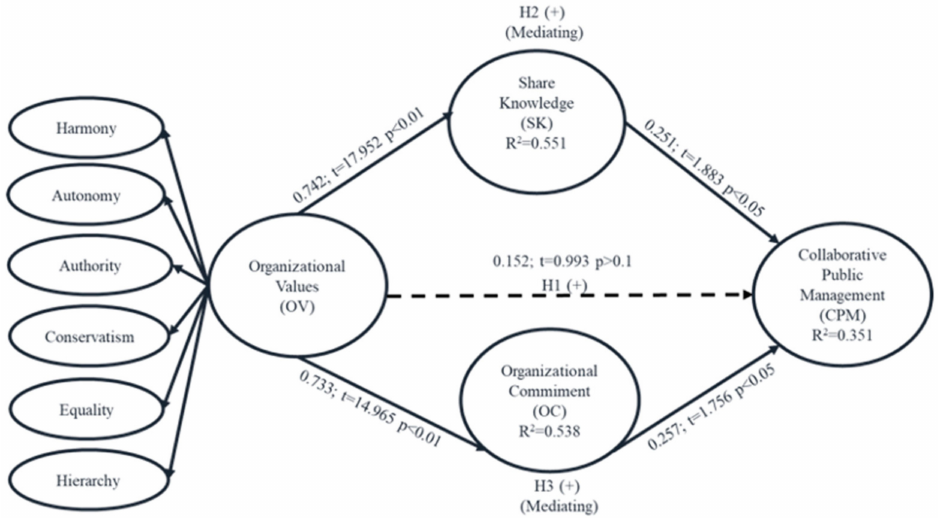
Figure 2. Theoretical model